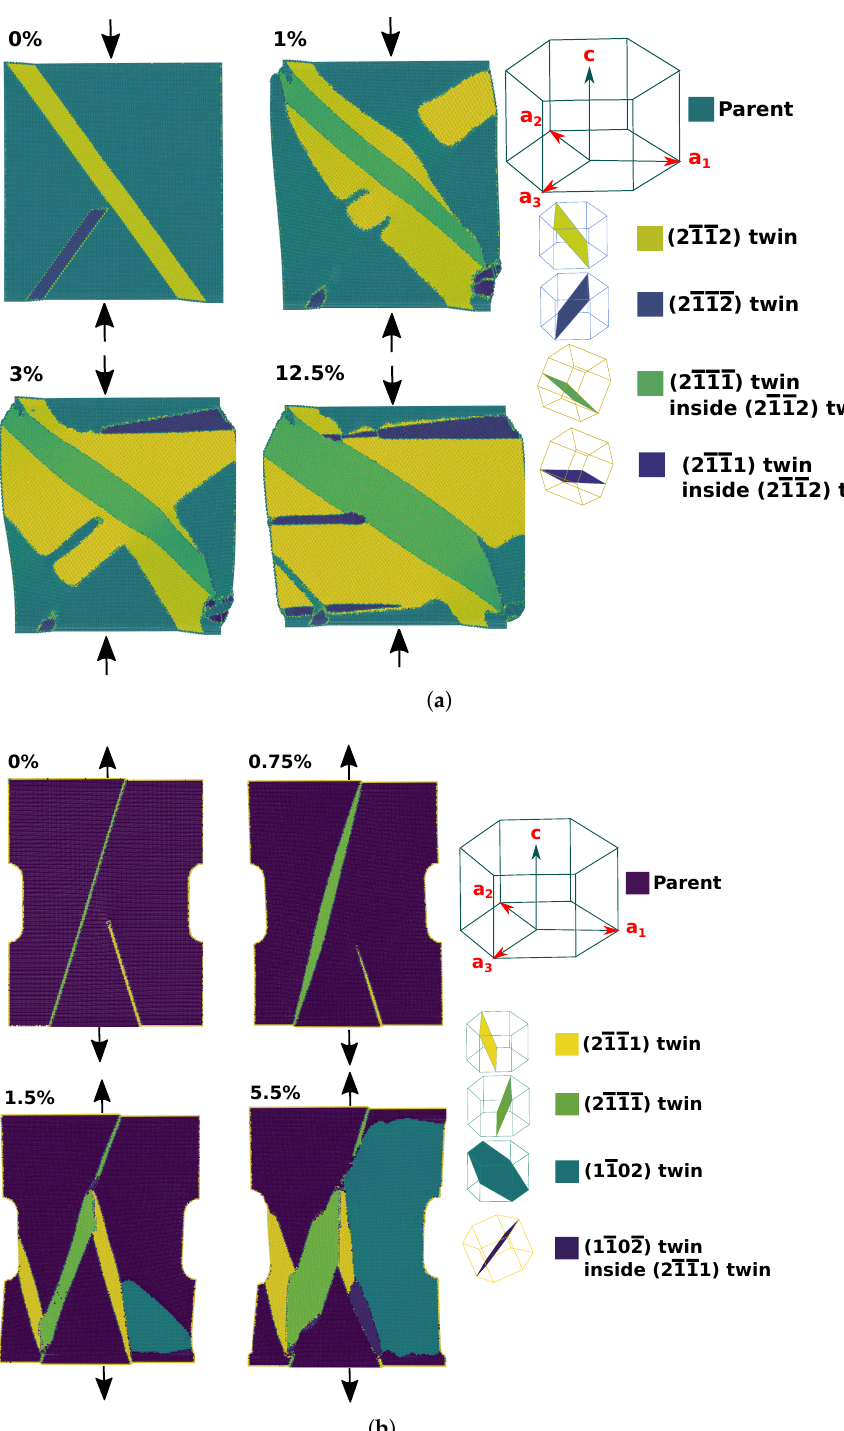
Figure 1. Depiction of the initial setups. ( a ) Compression twin setup with inserted 4.3 nm { 2112 } twin band and 2 nm { 2112 } twin embryo. The compression evolution is depicted at 0%, 1%, 3% and 12.5% compression. ( b ) Tension twin setup with inserted 1 nm { 2111 } twin band and { 2111 } twin embryo. The tension evolution is depicted at 0, 0.75%, 1.5% and 5.5% tension. These frames were selected since they show most of the interactions found in the microstructural evolution of the tension and compression cases here studied. The MEAM/spline potential was used here; however, the results from that RANN potential were